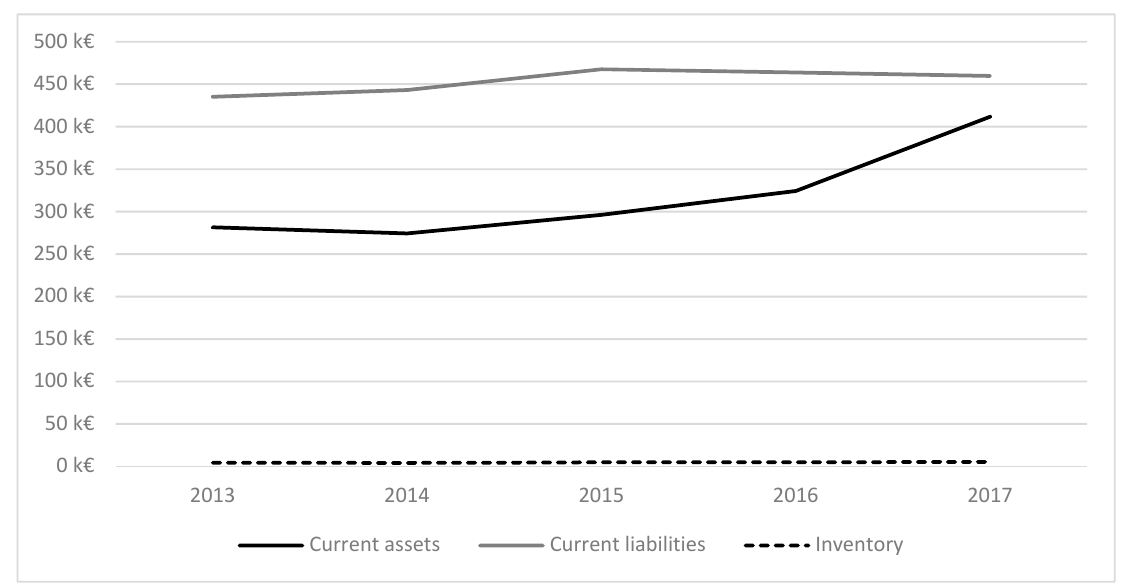
Figure 1. Median of the values presented by the hotel companies.